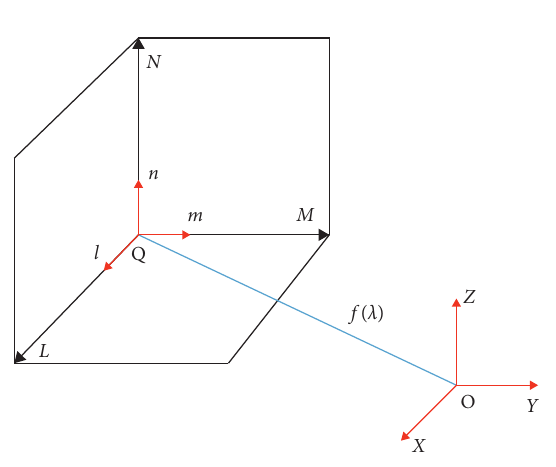
Figure 5: Frenet–Serret frame. Table 1: Parameters of right-hand ordinary lay 6 × 7+IWS. Parameter